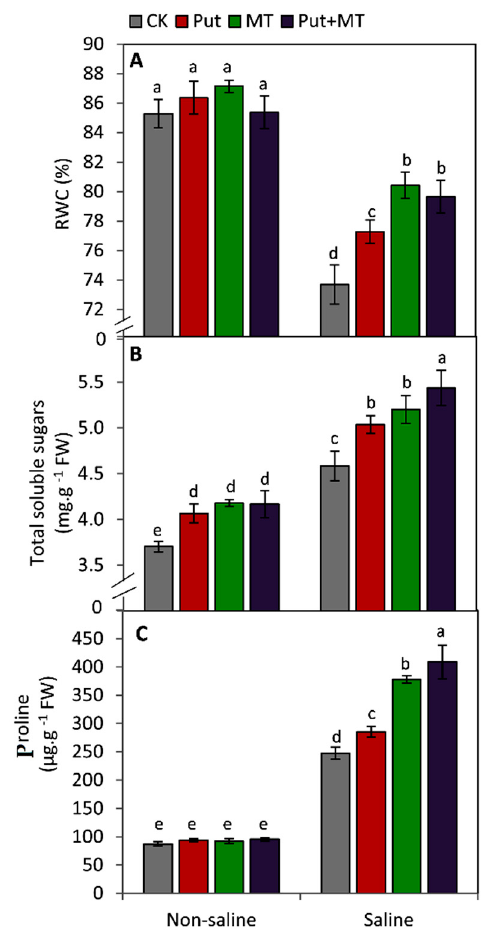
Figure 2. Effect of melatonin (MT; 20 µ M), putrescine (Put; 100 µ M), and their combination on the leaf relative water content (RWC) and osmolytes of snap bean seedlings grown under control and salt stress (50 mM NaCl). ( A ) RWC, ( B ) total soluble sugars, and ( C ) proline. The upper error bar denotes standard deviation, while various lowercase letters above the bars denote significant differences according to Duncan’s multiple range tests ( p ≤ 0.05).